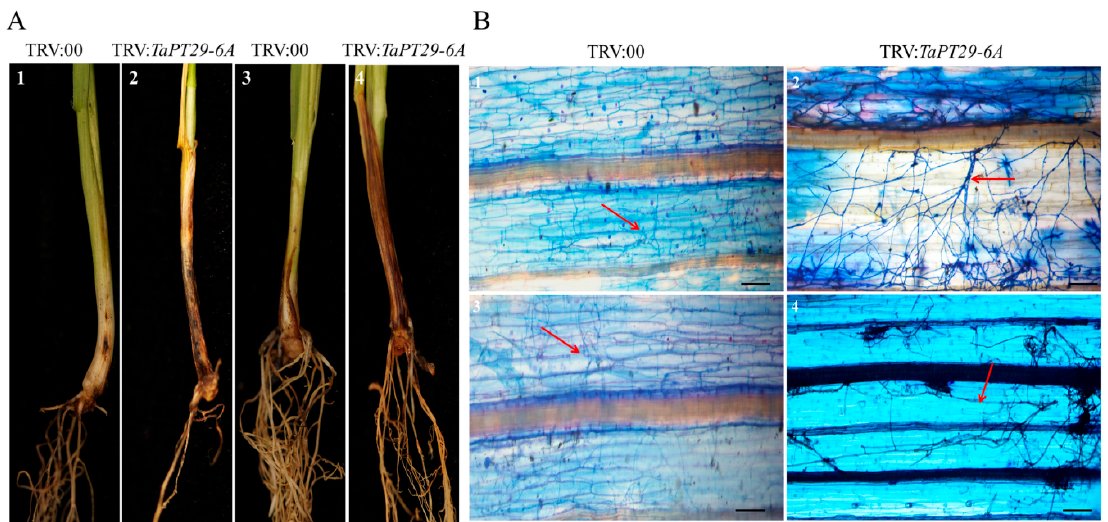
Figure 8. Silencing TaPT29-6A increased susceptibility to Ggt and B. sorokiniana . ( A ) Typical infection phenotypes of 16 days after silencing control plants and TaPT29-6A -silenced plants after inoculation with Ggt (1–2) and B. sorokiniana (3–4) for 21 days and 40 days. ( B ) Microscopic images of Ggt (1–2) and B. sorokiniana (3–4) hyphae on the base leaf sheaths of TaPT29-6A VIGS and TRV:00 plants. Red arrows indicate the hyphae of Ggt and B. sorokiniana pathogens. Scale bar = 25 µm.